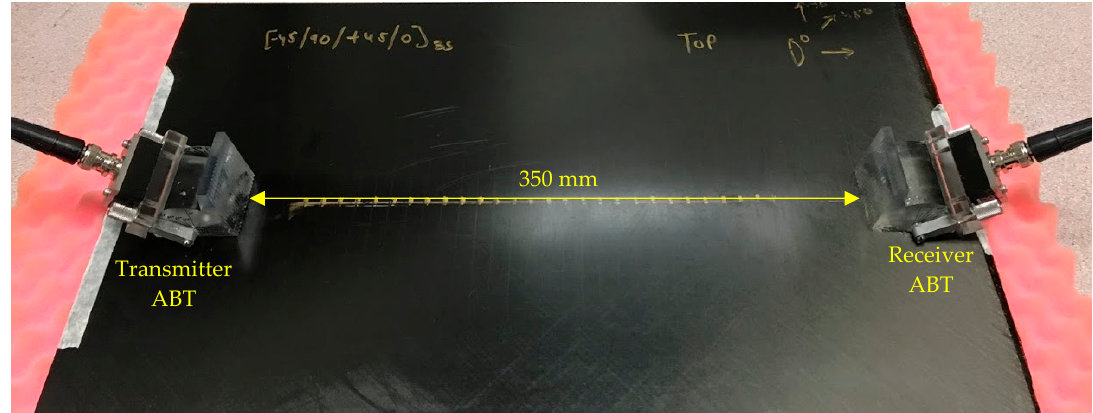
Figure 20. SH0 mode excitation over a long distance on the 3-mm quasi-isotropic composite plate.